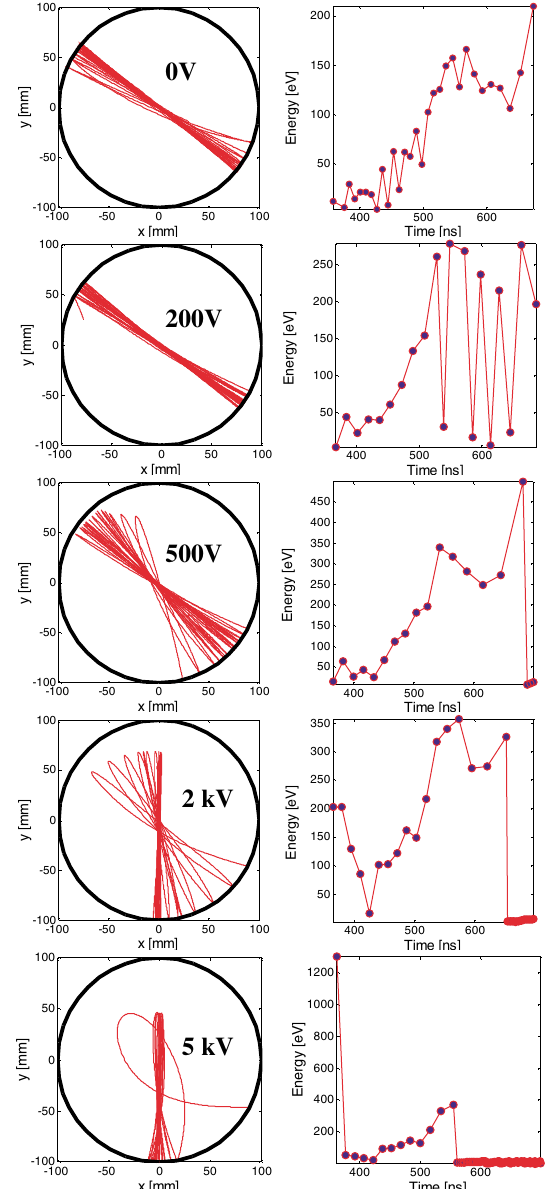
FIG. 7. (Color) Examples of an electron’s orbit (left column) in the transverse plane and its energy at the walls’ surface (right column) with various clearing voltages. The red lines in the left column denote the orbits, and the solid black lines show the vacuum chamber’s